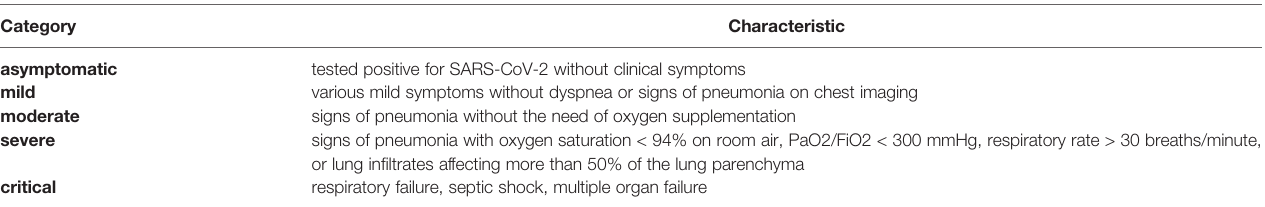
TABLE 1 | Categories of COVID-19 disease course in relation to the severity of the illness. Category Characteristic asymptomatic tested positive for SARS-CoV-2 without clinical symptoms mild various mild symptoms without dyspnea or signs of pneumonia on chest imaging moderate signs of pneumonia without the need of oxygen supplementation severe critical respiratory failure, septic shock, multiple organ failure According to